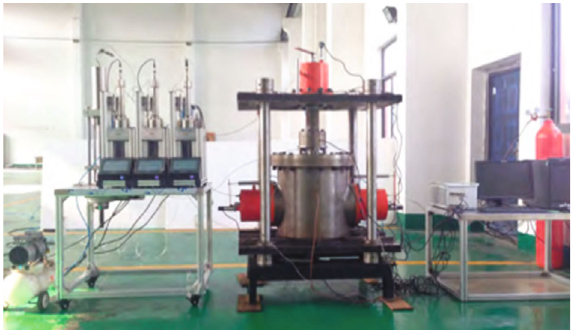
Figure 1: Physical diagram of gas – solid coupling coal seepage test